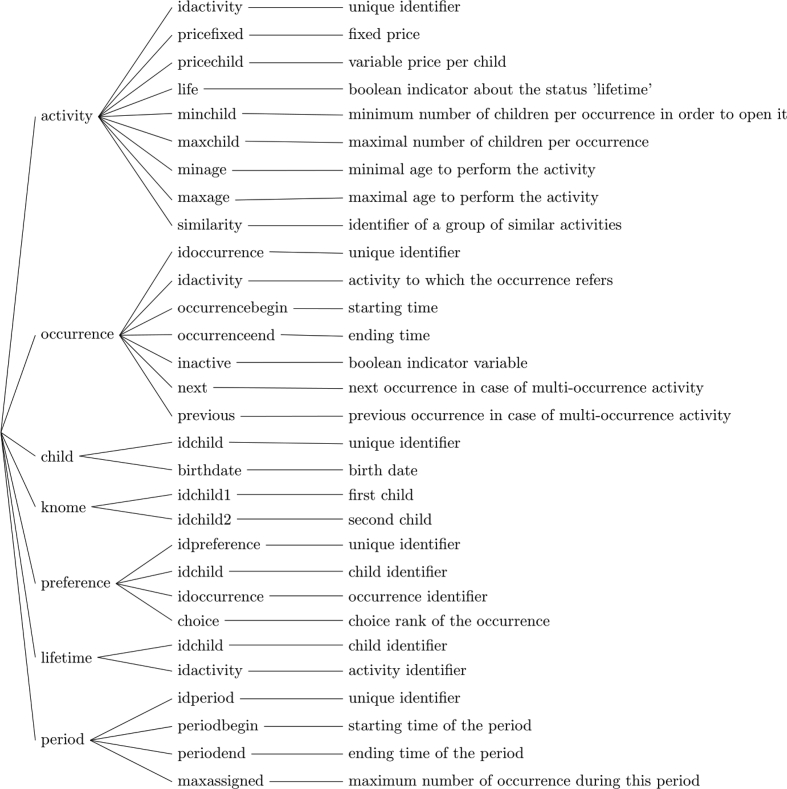
CSV's files schema.